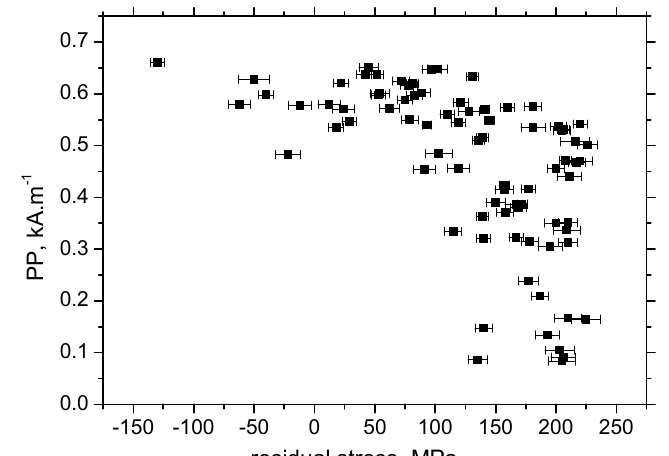
Figure 22. PP versus residual stresses, RD.